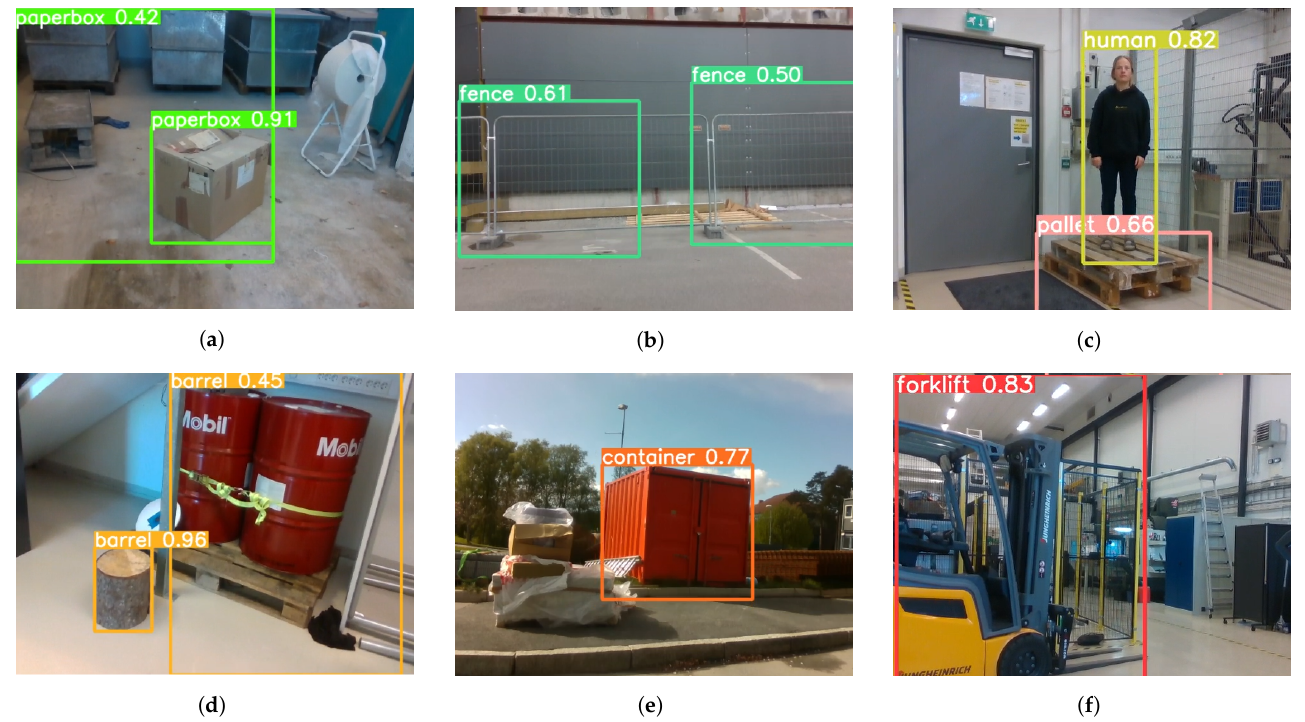
Figure 14. Live inference in a local environment: ( c , e ) small model; ( a , b , d , f ) xlarge